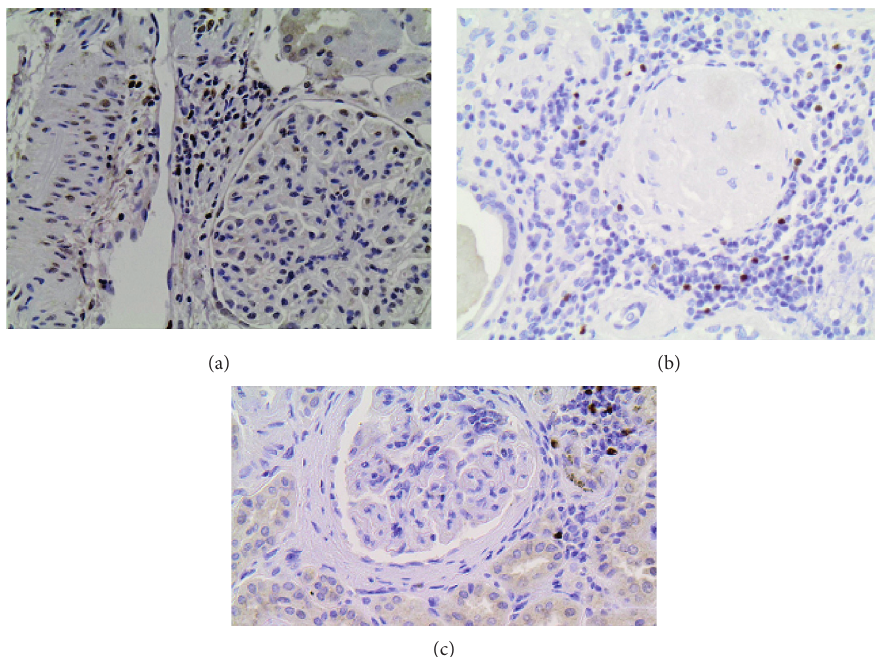
Figure 4: Immunohistochemical stain of FOXP3+ regulatory Tcells (Tregs) in periglomerular space inflammatory cell infiltrates in: (a) IgA nephropathy (IgAN), (b) focal segmental glomerulosclerosis (FSGS), and (c) membranous glomerulopathy (MGN). Cells stained dark brown are considered positively stained FOXP3+ Tregs, and blue-stained cells are negatively stained lymphocytes. Table 4: Association between absolute FOXP3+ Tregs count in the interstitial tissue (per mm 2 ) and histological lesions. Absolute FOXP3+ Tregs count in the Segmental sclerosis or not